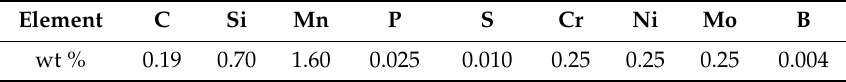
Table 3. Chemical composition of the test material Hardox